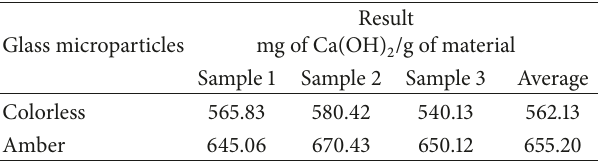
Table 3: Modified Chapelle test